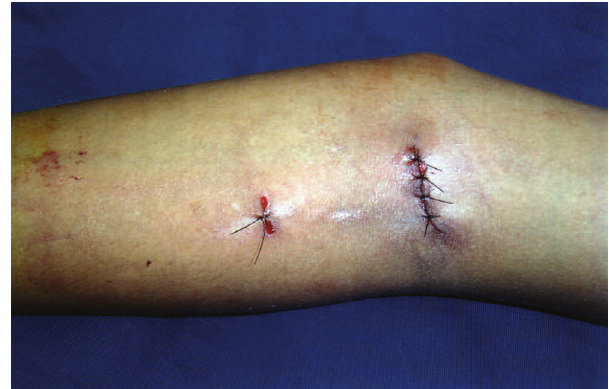
Figure 1 - Incisions used for the creation of brachiocephalic fistula.